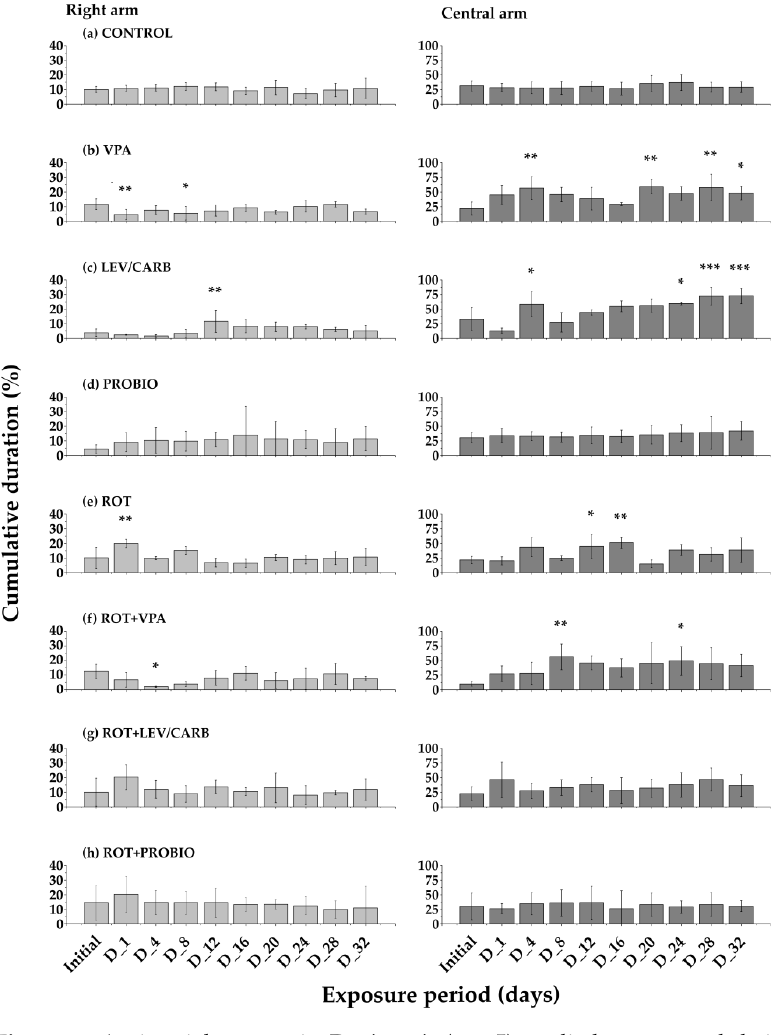
Figure 3. Anti-social pattern in Danio rerio (n = 5) studied groups and their tendencies toward both arms (values expressed as mean with SEM followed by Dunnett’s test; * p < 0.05, ** p < 0.005, *** p < 0.0005).